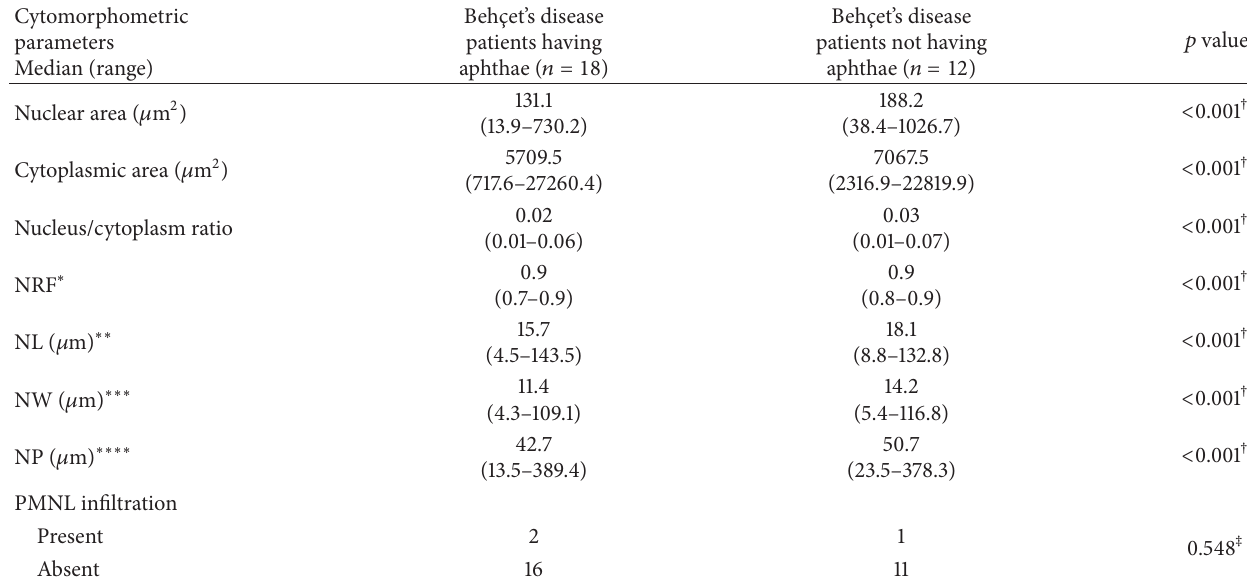
Table 3: Comparison of the cytomorphometric parameters and the presence of polymorphonuclear leukocytes (PMNL) in Behc¸et’s disease patients with and without